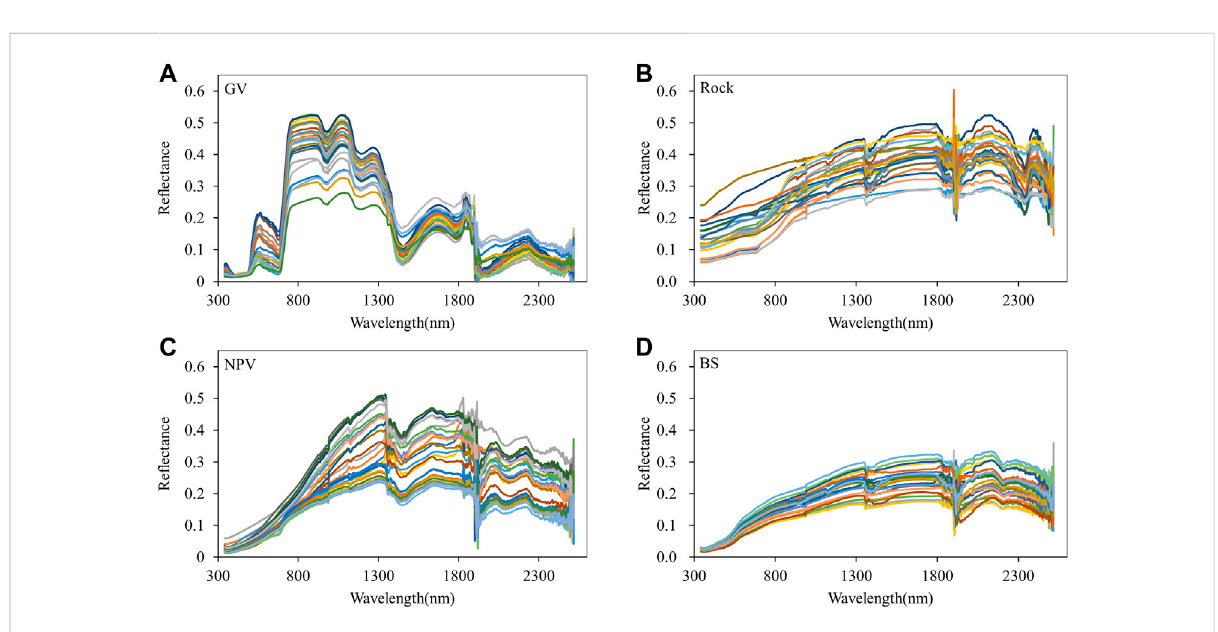
FIGURE 3 Survey route and UAV fl ight area distribution